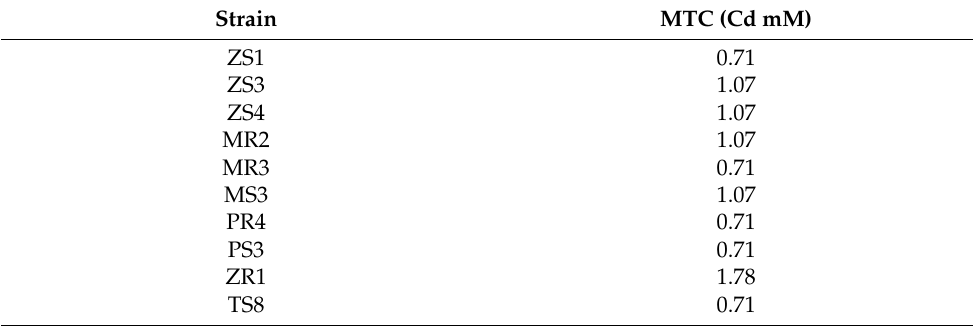
Table 2. Cadmium maximum tolerance concentration of screened bacteria.